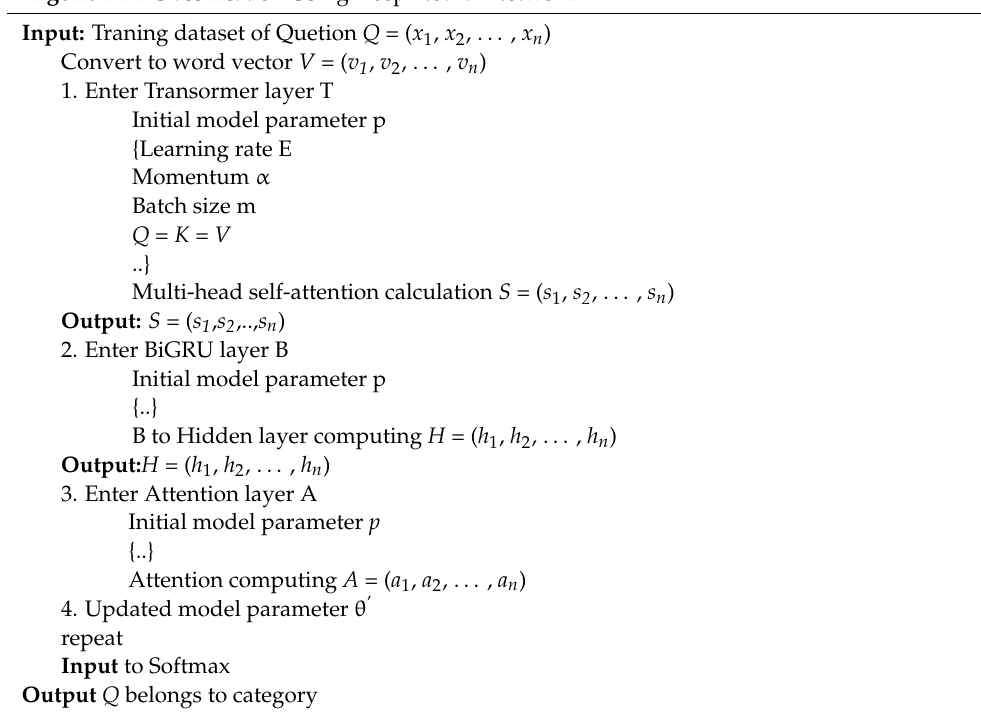
Algorithm 1 Classification Using Deep Neural